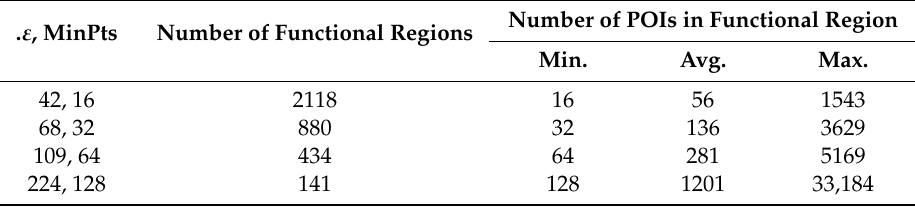
Table 2. The number of generated functional regions and their POIs with varied ε and MinPts. . ε ,